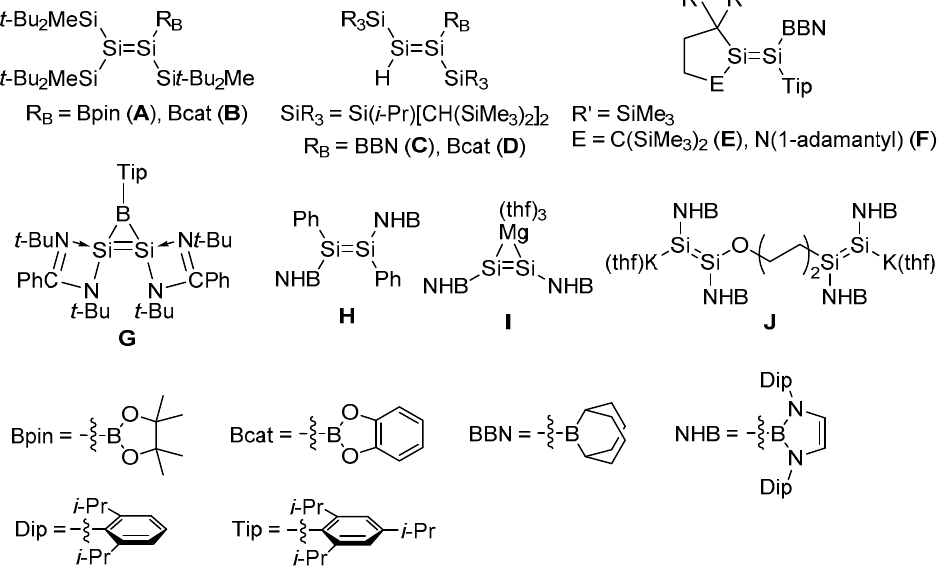
Figure 1. Reported isolable boryl-substituted disilenes.